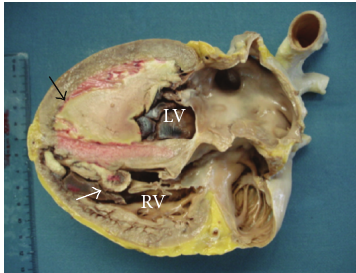
Figure 4: Patients heart, showing a thrombus located in the left ventricle (black arrow), with an endothelium cover, and myocardial infiltration.Additionally,arightventricularthrombus(whitearrow) attached to the septum and covered by endothelium. In addition, thereisrightventricularthicknessofthefreewall.LV=leftventricle; RV = right